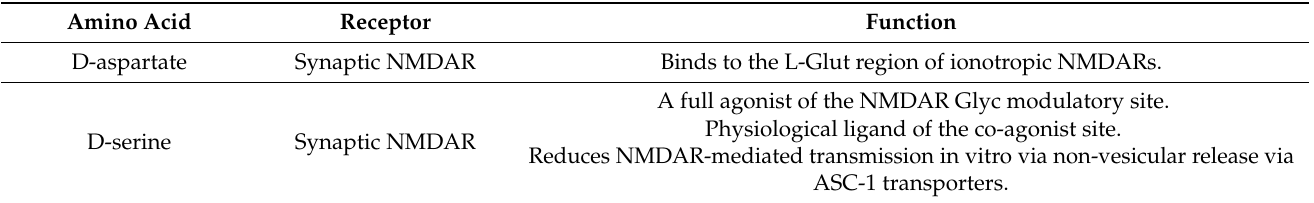
Table 1. Functions of D-aspartate and D-serine in the central nervous system. Amino Acid Receptor Function D-aspartate Synaptic NMDAR Binds to the L-Glut region of ionotropic NMDARs. A full agonist of the NMDAR Glyc modulatory site. Physiological ligand of the co-agonist D-serine Synaptic NMDAR